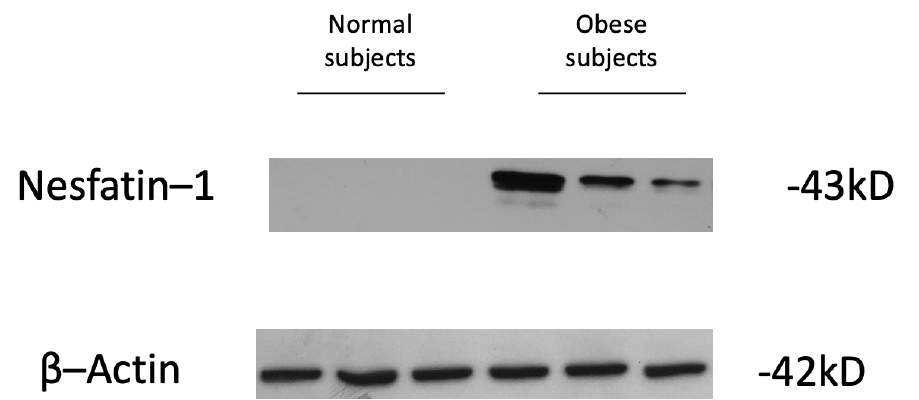
Figure 2. Nesfatin-1 protein expression in adipose tissue explants from obese and normal-weight subjects. Protein extracts from adipose tissues were loaded. Corresponding protein levels for nesfatin-1 were determined by Western blot analysis using anti-nesfatin-1 antibody as described in the Materials and Methods. β -actin was employed as a control of protein loading. A representative blot of three obese and three normal-weight patients is shown.